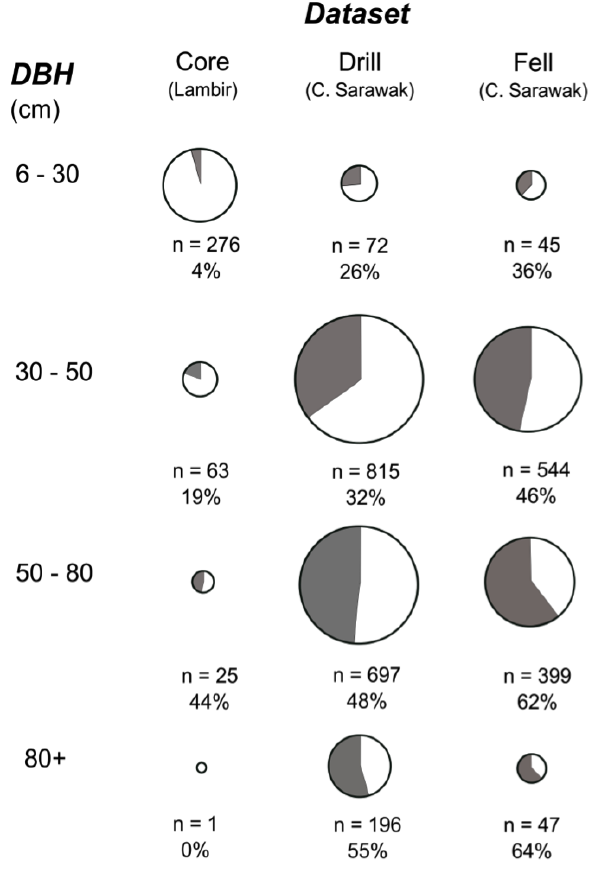
Figure 2. Stem diameter-related variation in the frequency of stem rot found in trees in mixed dipterocarp rain forest of Central Sarawak, Bornean Malaysia. Pie charts show the percentage of trees with stem rot (shaded), with pies sized according to the total num- ber of sampled stems ( n ), in each diameter at breast height (DBH) size class and three data sets, one from Lambir Hills National Park (Lambir) and two from Central Sarawak (C. Sarawak; see Sect. 2 for